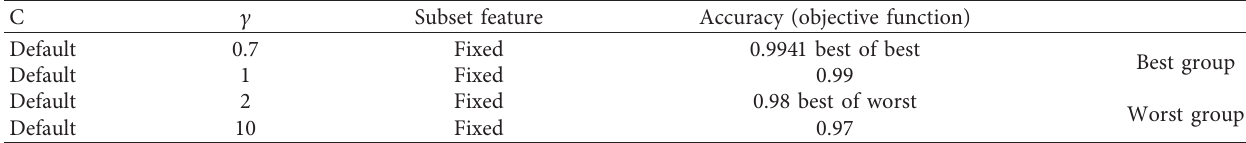
Table 6: Best and Worst groups for c .